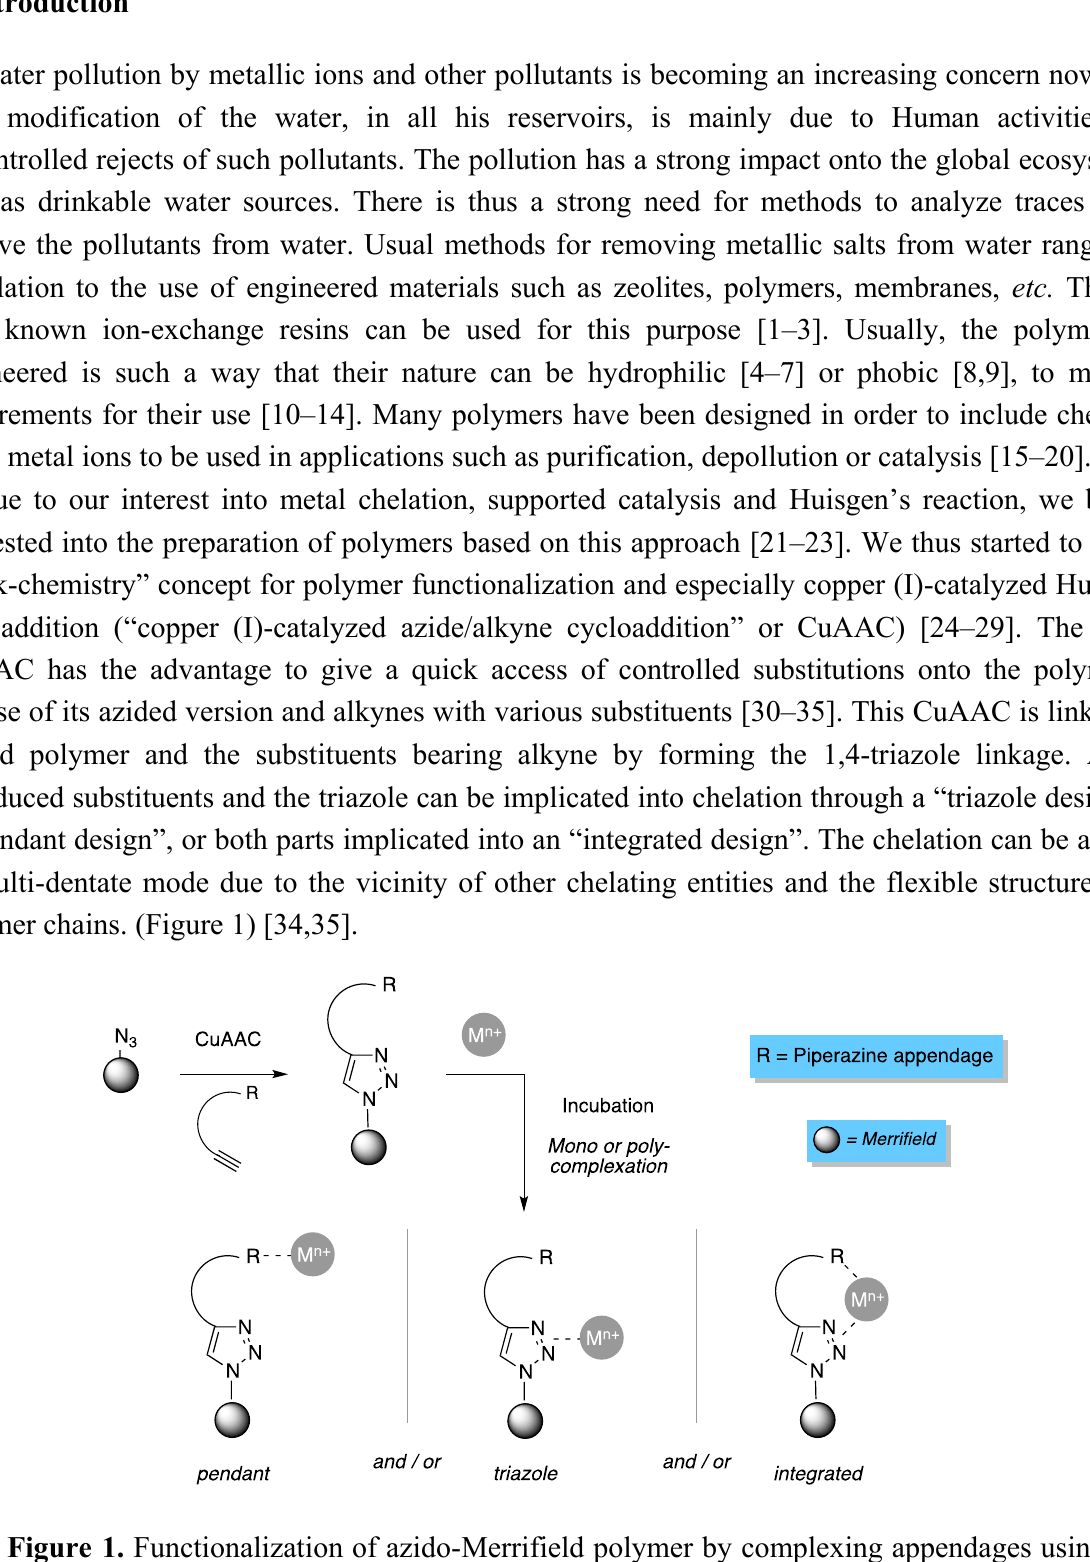
Figure 1. Functionalization of azido-Merrifield polymer by complexing appendages using copper (I)-catalyzed azide/alkyne cycloaddition (CuAAC) for a 1,2,3-triazole linkages and possible chelation